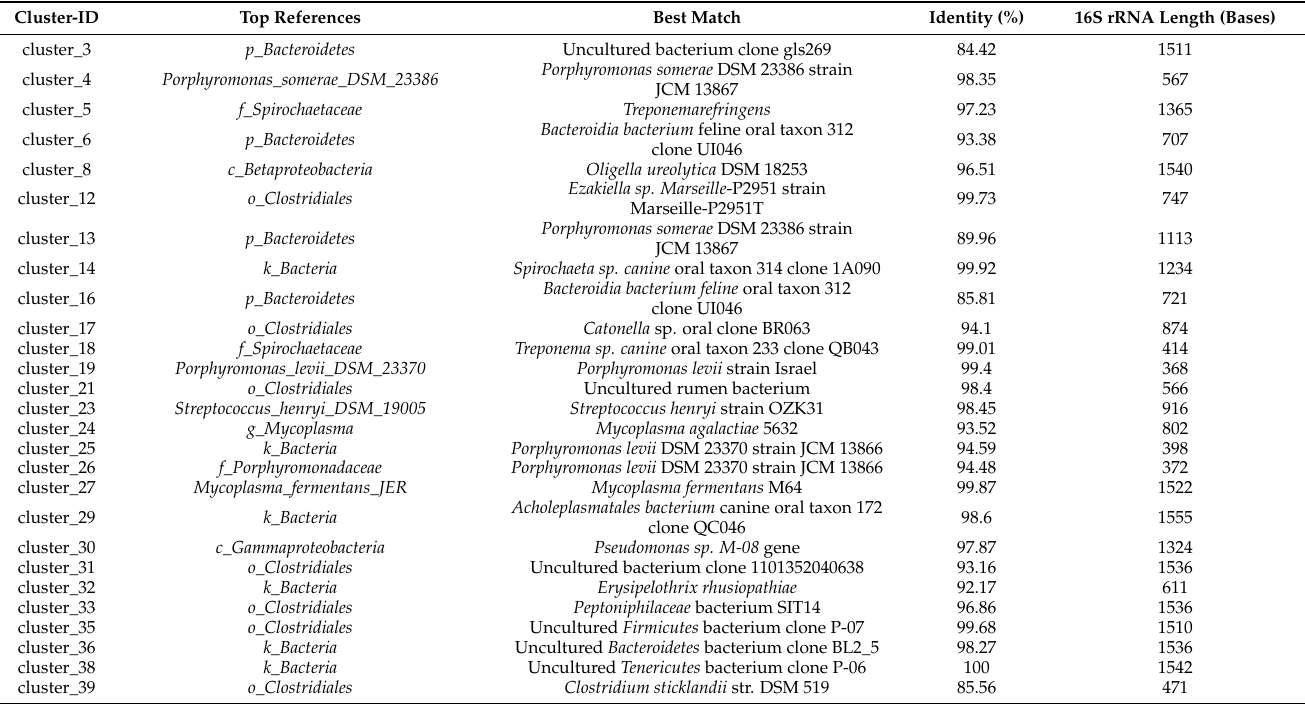
were used to classify each such cluster more specifically. A best match organism, percent identity, and gene size of these bacterial clusters using 16S rRNA sequence BLAST (Basic Local Alignment Search Tool) are presented in Table 2. For instance, cluster 5 Spirochaetaceae had a 97.23% match with Treponema refringens , cluster 18 ( Spirochaetaceae) a 99.01% match with Treponema species, cluster 13 ( Bacteroidetes) an 89.96% match with P. somerae , and cluster 26 ( Porphyromonadaceae) a 94.48% match with P. levii . More interestingly, six clusters only identified as kingdom Bacteria were further classified as Spirochaetes species (cluster 14), P. levii (cluster 25), Acholeplasmatales species (cluster 29), Erysipelothrix rhusiopathiae (cluster 32), Bacteroidetes species (cluster 36), and Tenericutes species (cluster 38). Table 2. Best match bacterial species, percent identity, and gene sizes of 27 bacterial clusters using 16S ribosomal RNA sequence blasting on the National Center for Biotechnology Information (NCBI) website.